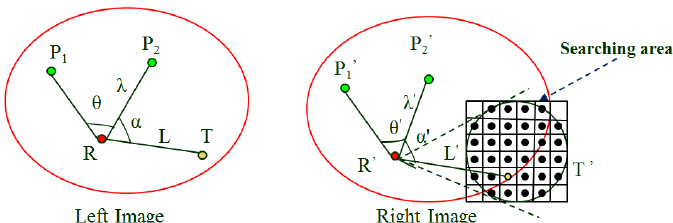
Figure 10. Illustration of the matching propagation. The root node marked in red and two starting nodes marked in green determine the local disparity ∆ λ and ∆ θ , then the circular searching area can be